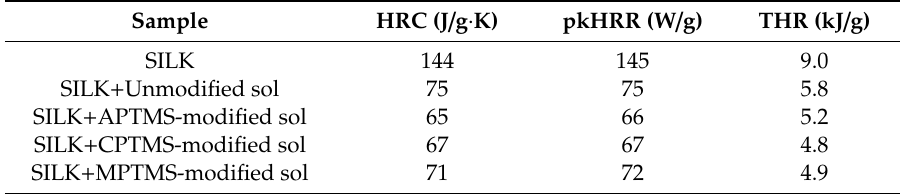
Table 16. Results from microscale combustion calorimetry for untreated and sol-gel treated silk